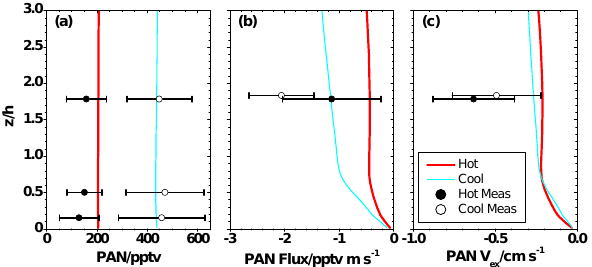
Fig. 8. Vertical profiles of (a) mixing ratios, (b) fluxes and (c) ex- change velocities for PAN. Model results are shown for both hot and cool periods. Filled and open circles represent observations (mean ± 1 σ ) for the hot and cool periods, respectively. Observa- tions for the cool period in (b) and (c) are offset on the y-axis for